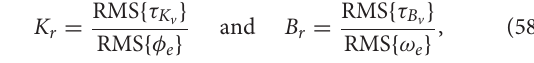
TABLE 3 | Experimental measurements of the system stiffness and